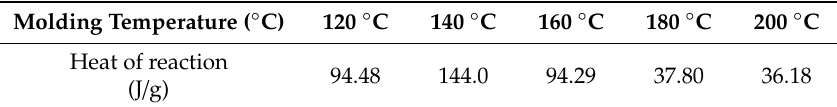
Figure 14. DSC thermograms of caprolactam with di ff erent polymerization temperatures: ( a ) isothermal scanning as a function of polymerization time, ( b ) dynamic scanning as a function of temperature. Table 4. DSC diagrams of the isothermal scanning